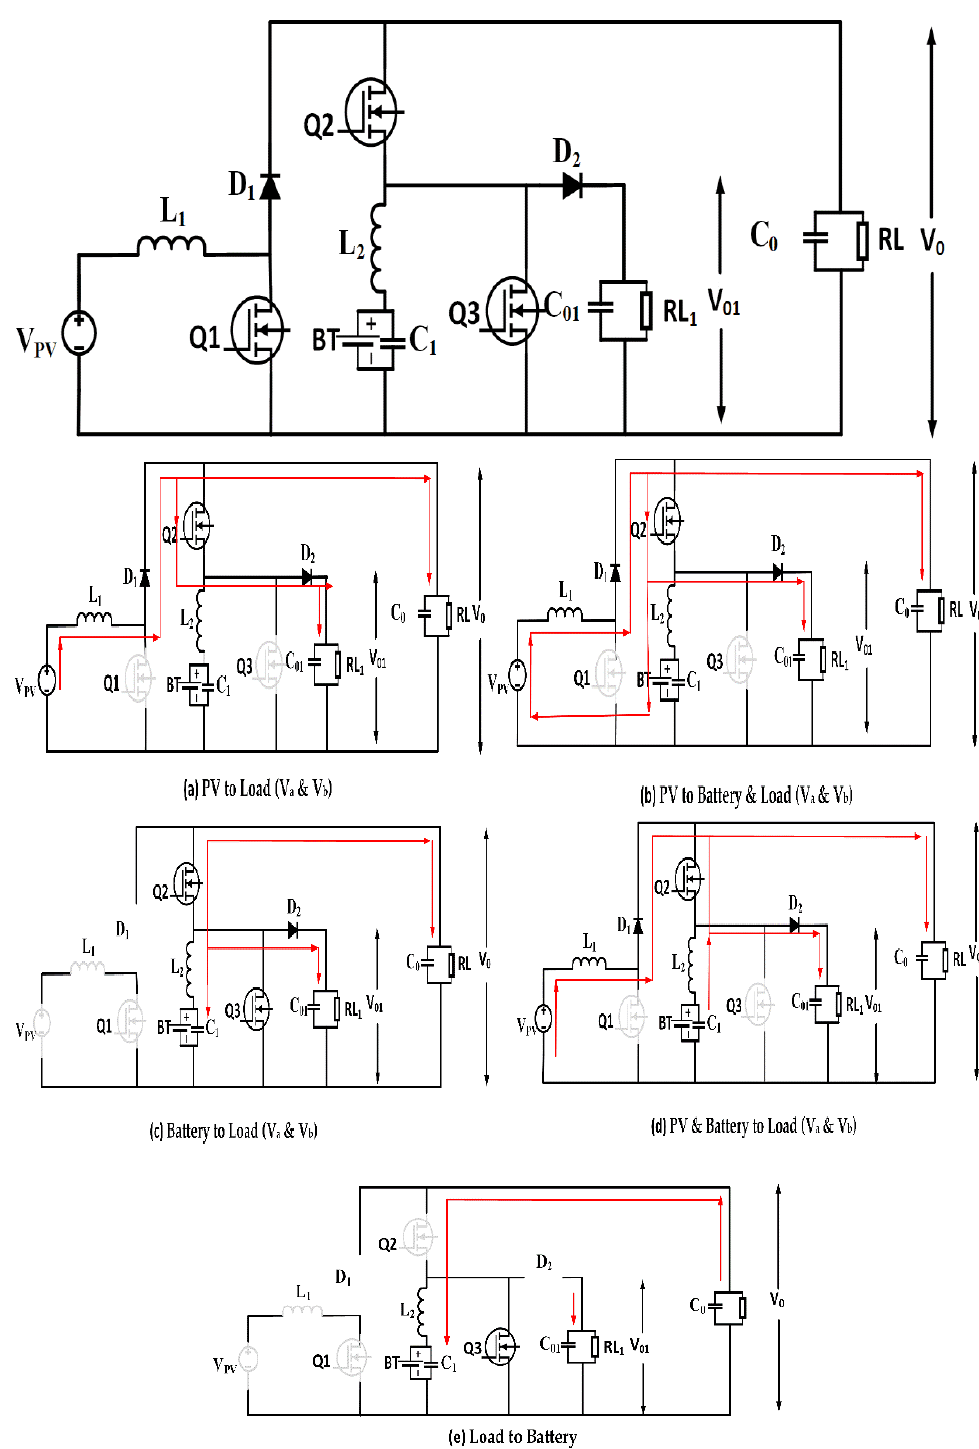
Figure 13. Typical Non isolated multiport converter. From ( a – e ) different modes of operation for the NI-MP converter with typical power flow diagrams. Table 3. Summary of operation modes in MPC [30].